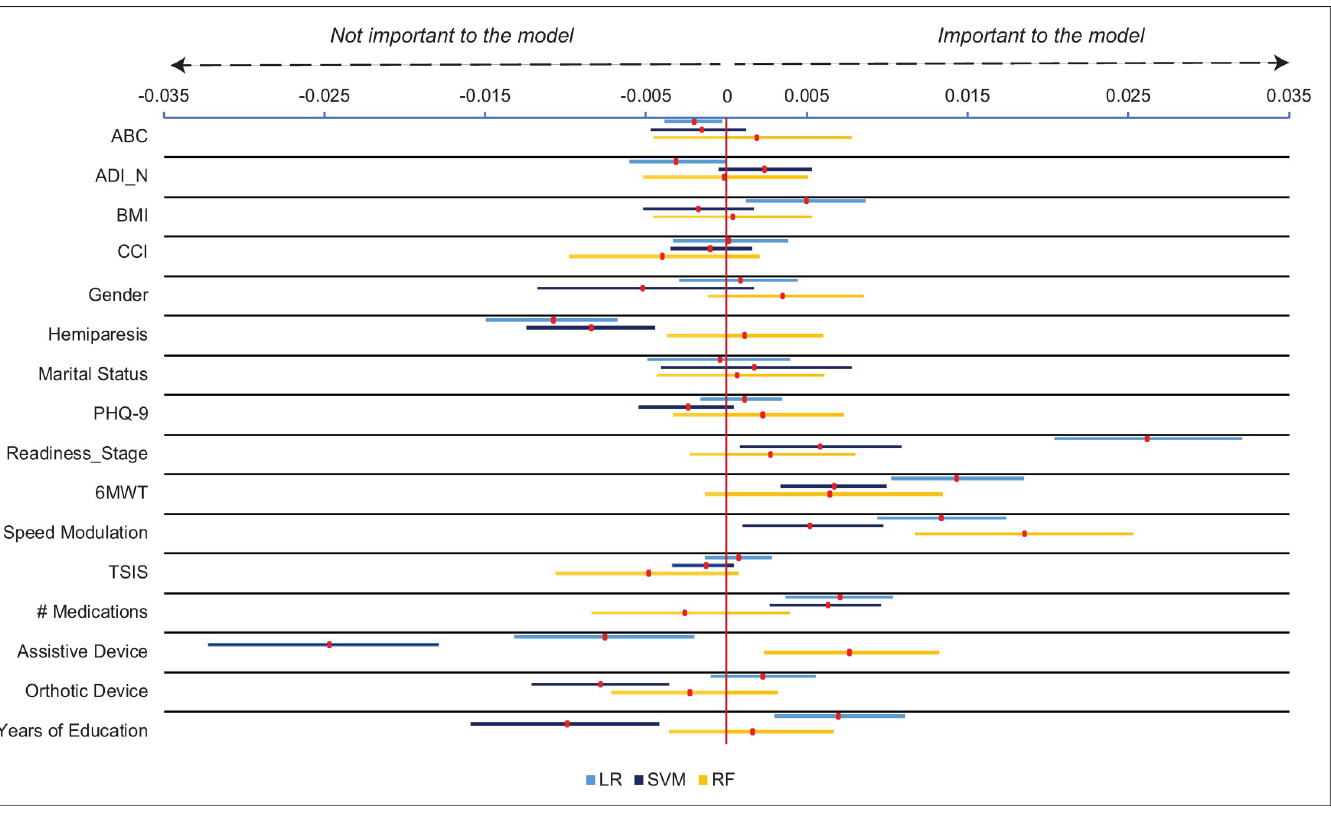
Fig 4. Drop column feature importance for aerobic threshold (5500 steps/day). Red markers show mean feature importance with 95% bootstrapped confidence interval. Speed modulation was the only feature found to be important across all three algorithms. Abbreviations: ABC- Activities Specific Balance Confidence Scale, ADI_N- Area Deprivation Index (national percentile), BMI- body mass index, CCI- Charlson Comorbidity Index (age-adjusted), PHQ-9 (Patient Health Questionnaire- 9), Readiness_Stage- Readiness to change stage score, 6MWT- 6-Minute Walk Test, TSIS- time since initial stroke, LR- Logistic regression, SVM- Support vector machine, RF- Random